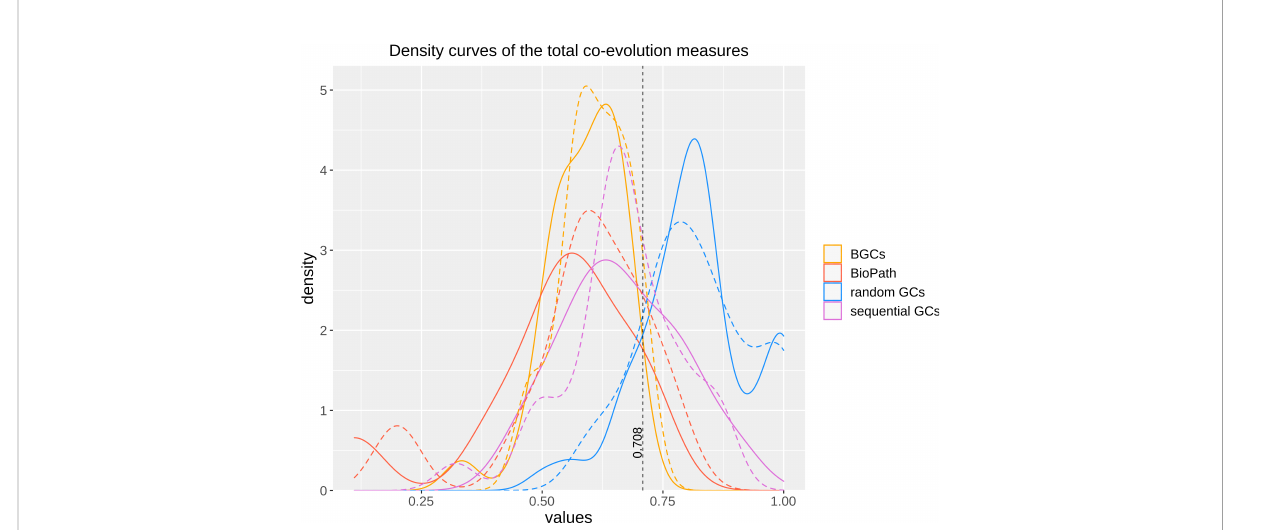
FIGURE 2 Kernel density plot of the ICQ values for co-evolutionary linked enzymes of different control sets comparing the original FunOrder method (dashed lines) and FunOrder 2.0 (solid lines). BGCs, previously empirically characterized fungal BGCs; BioPath, protein sets of conserved biosynthetic pathways of the primary metabolism; random GCs, randomly assembled protein sets from 134 fungal proteomes; sequential GCs, co-localized genes from random loci of different